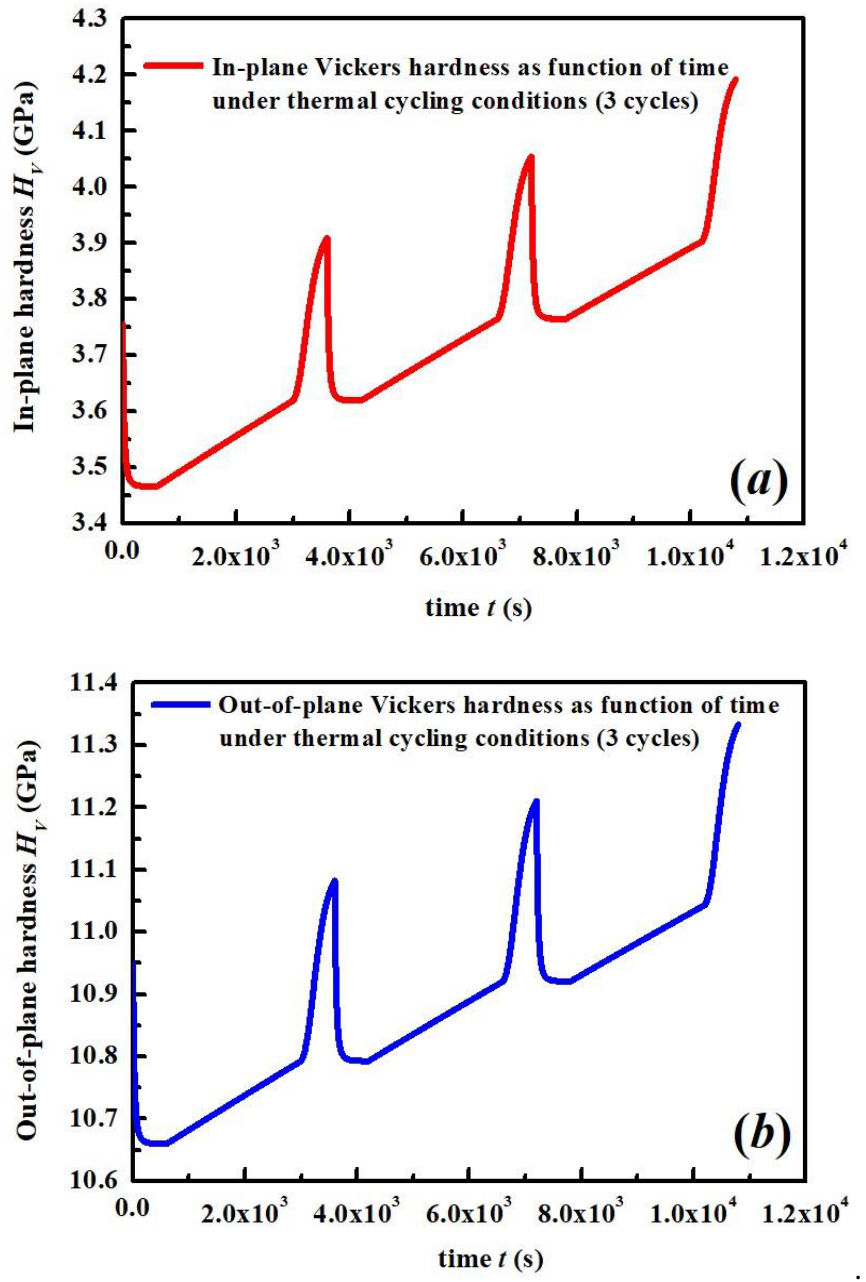
Figure 9. Calculated temperature-process-dependent topcoat hardness for the first three cycles; ( a ) in-plane Vickers hardness; ( b ) out-of-plane Vickers hardness. The yield strength of the target material plays a significant role in determining the critical velocity for deformation wear in Equation (8). The temperature-dependent yield strength of 7YSZ material was used in [44], where the yield strength decreased as tempera- ture raises. The experimentally measured yield strength with a linear fitting is illustrated in Figure